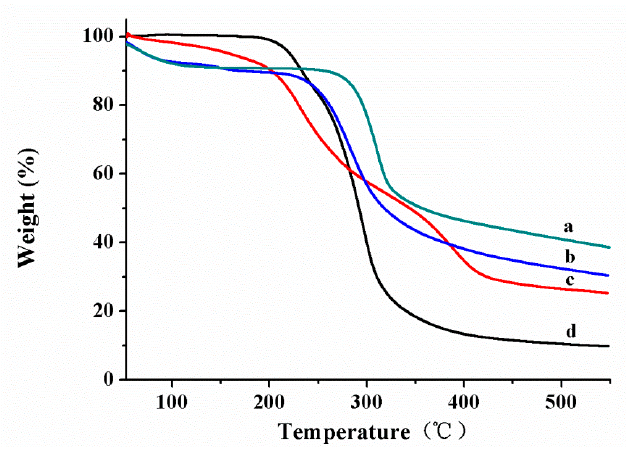
Figure 6. TGA of CS ( a ); CS- g -PDMAEMA ( b ); Pyr@CS- g -PDMAEMA ( c ); and pyraclostrobin ( d